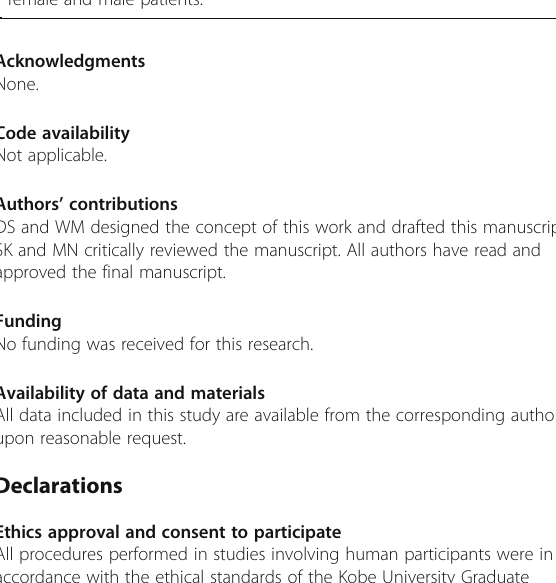
Additional file 1: Supplemental Table 1. Clinical characteristics of female and male patients. Acknowledgments